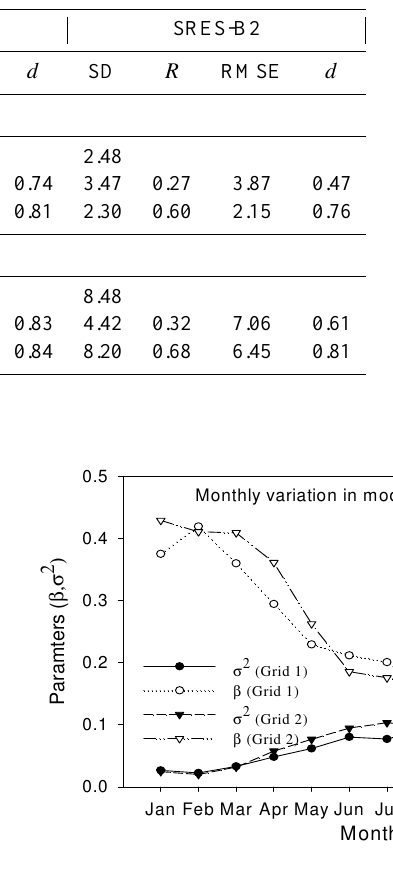
Fig. 8. Monthly variation in average spatial disaggregation model parameters ( β , σ 2